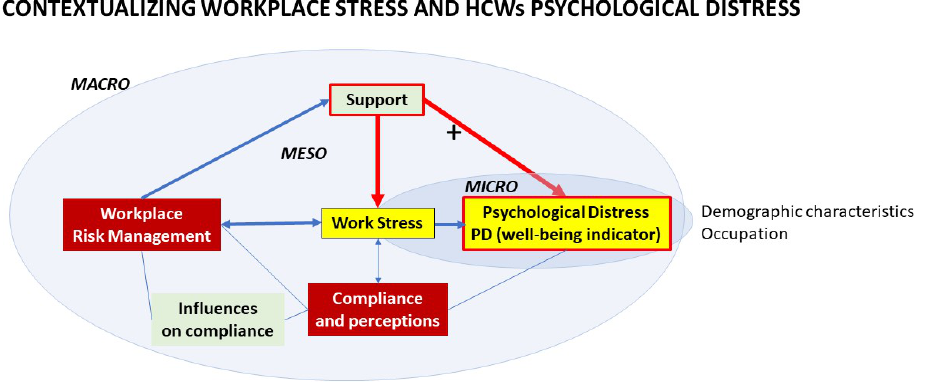
Figure 1. Contextualizing workplace stress and HCWs psychological